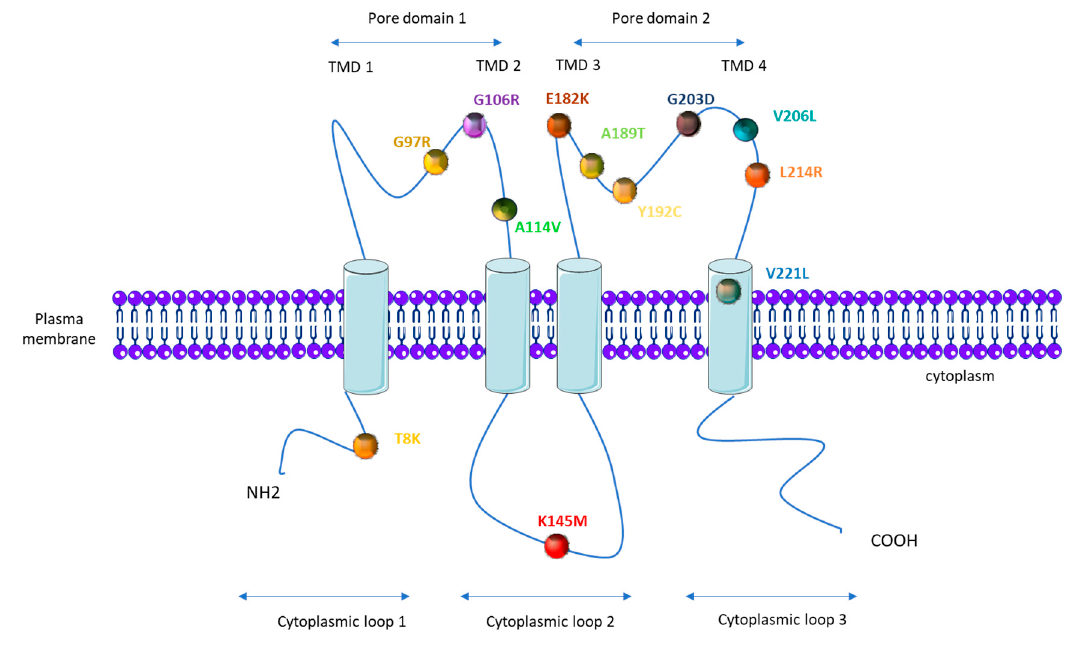
Figure 3. Topological analysis of the human KCNK3/TASK-1 channel. Positions indicate the mutations identified by Ma et al. [50], Navas et al. [51], Zhang [53], and Haarman [54]. Table 1. Potassium channel subfamily K member 3 (KCNK3) mutations identified in PAH patients and their consequences for the KCNK3 / TASK-1 channel